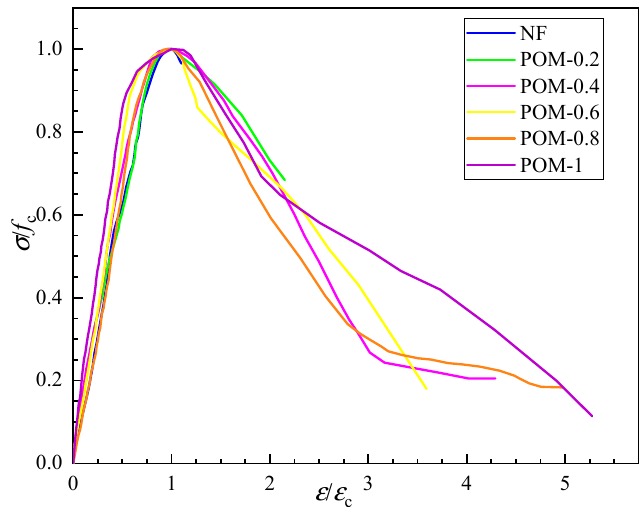
Figure 26. Dimensionless complete stress–strain curve.